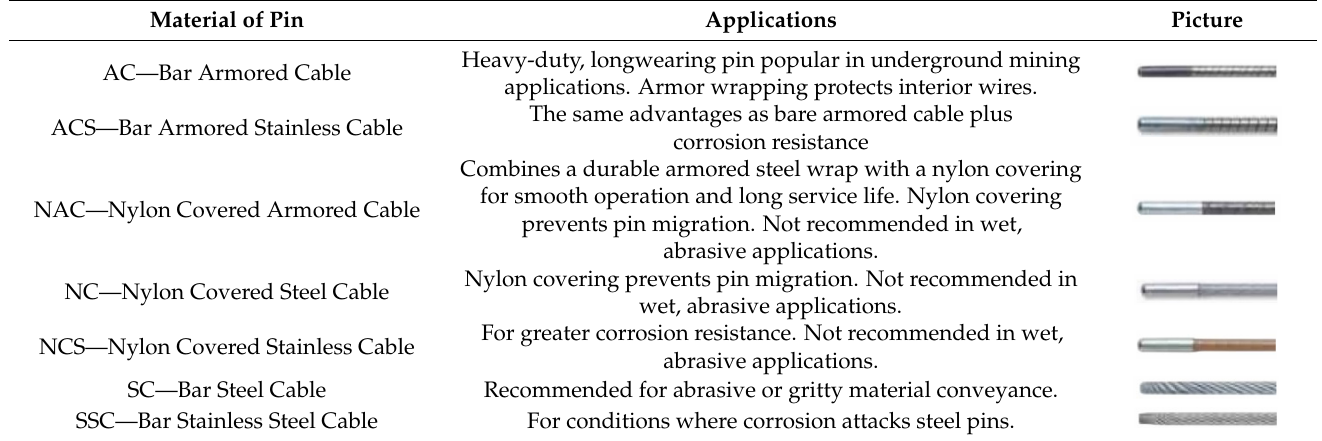
Table 5. Hinge pins various materials and different applications [25]. Applications